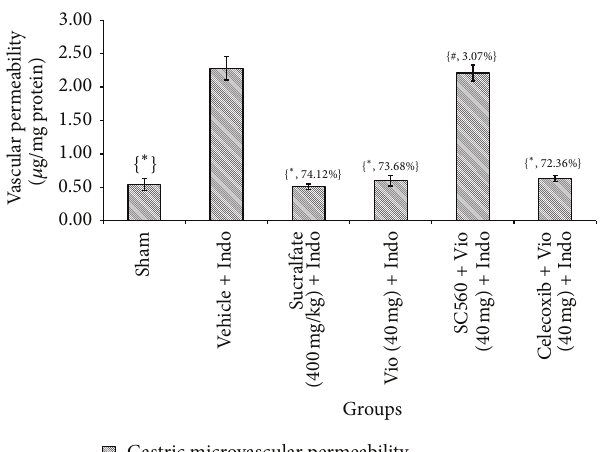
Figure 11: Effect of COX-1 and COX-2 inhibitors and violacein (40mg/kg, orally) on gastric microvascular permeability induced by indomethacin in rats. Values are mean ± SD ( n = 6). ∗ 𝑃 < 0.05 compare vehicle + Indo with all the groups; # 𝑃 < 0.05 compare Vio (40mg)+IndowithSC560orCelecoxib+Vio(40 mg)+Indo.Indo: indomethacin; Vio: